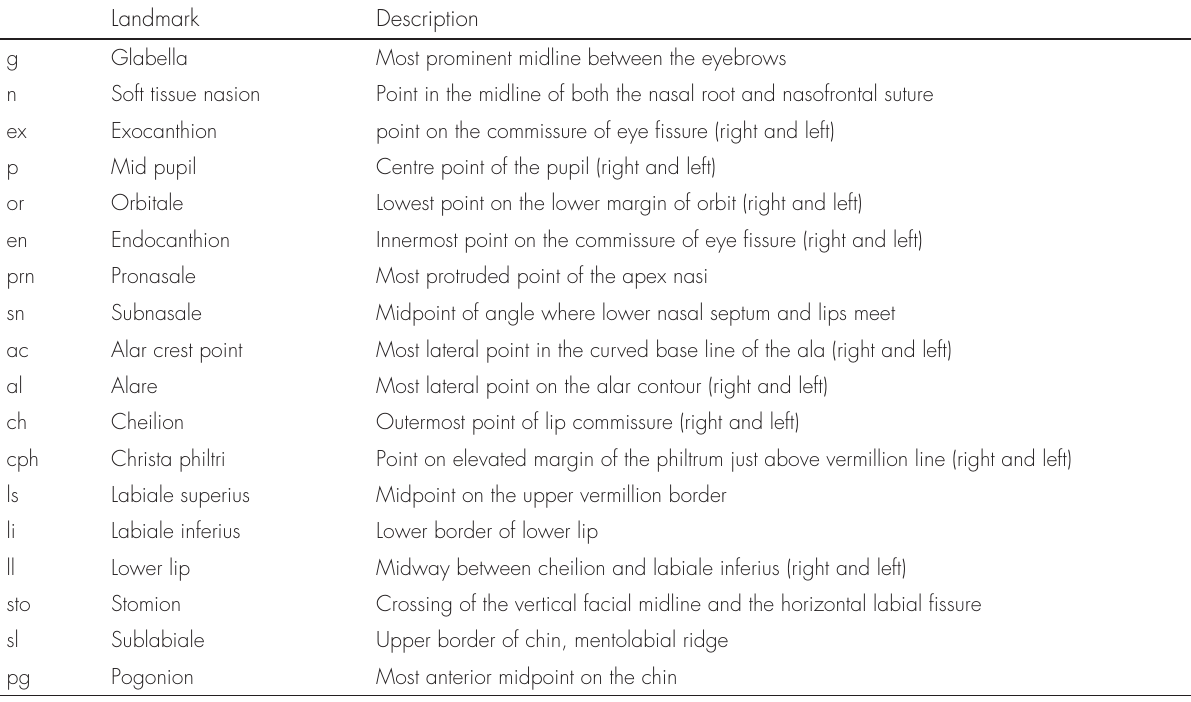
Table II. Facial landmark definitions.